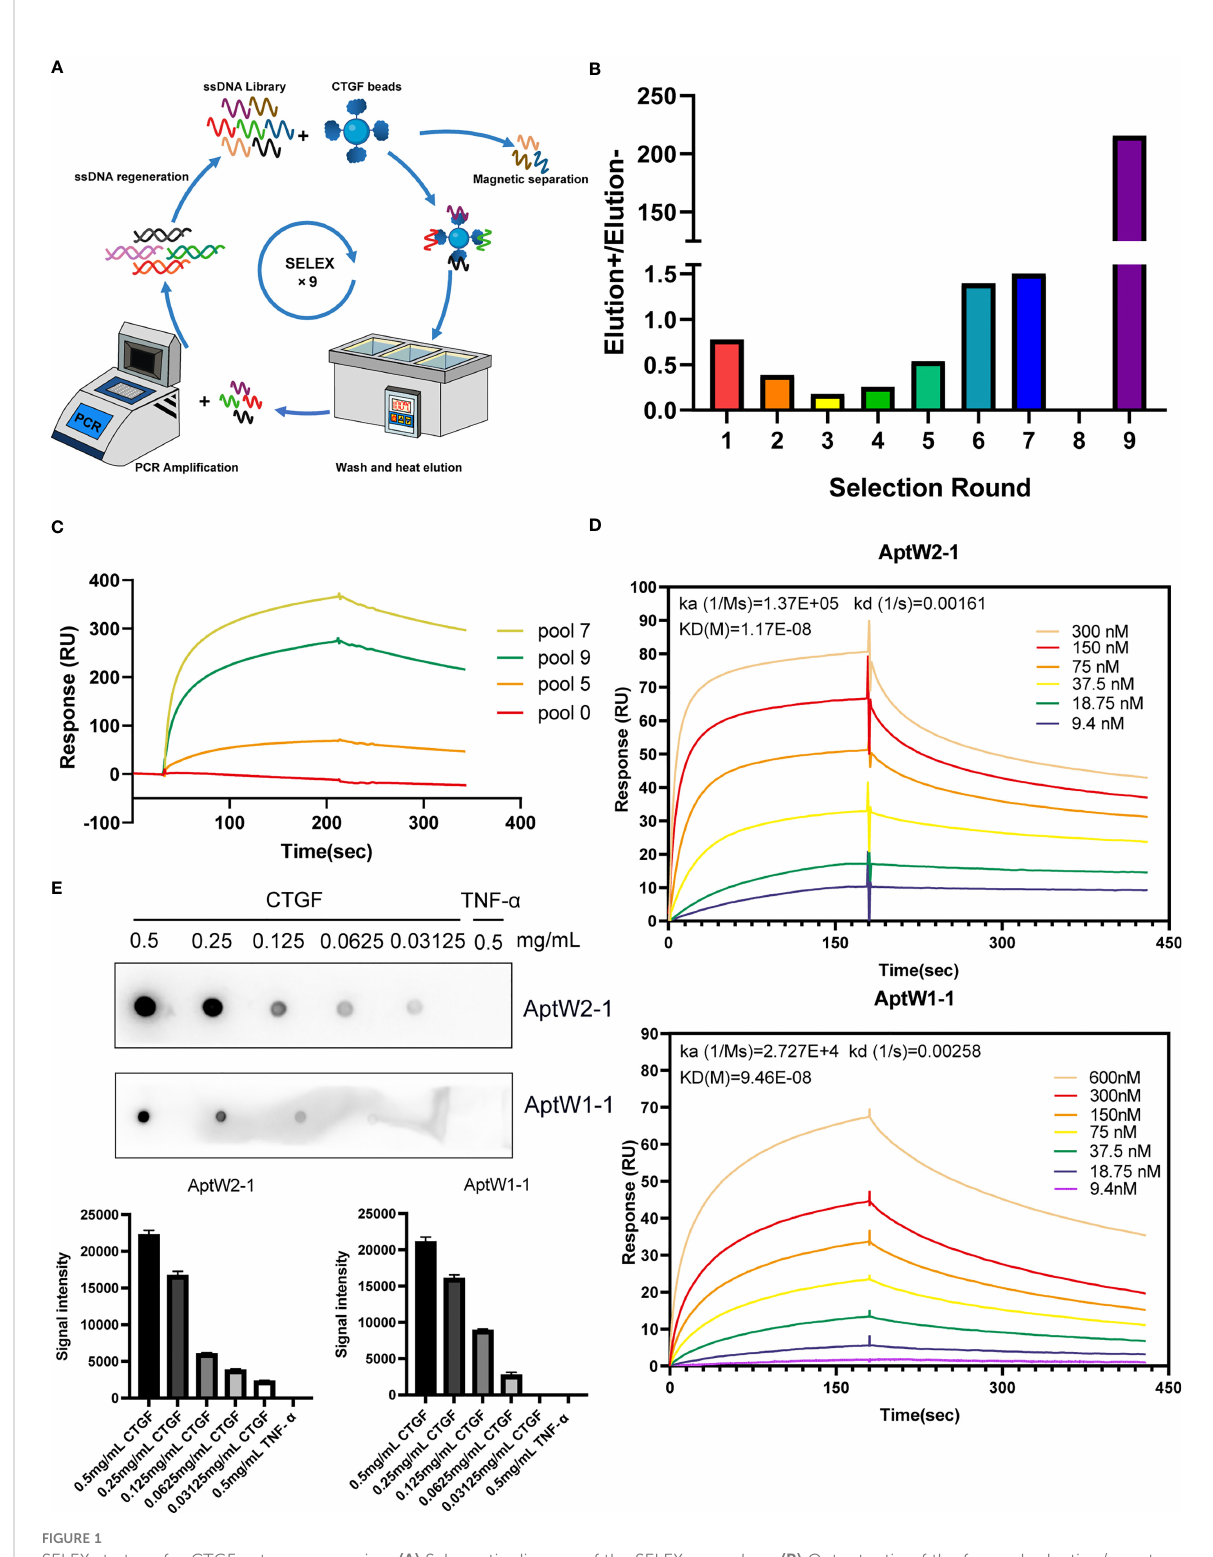
FIGURE 1 SELEX strategy for CTGF aptamer screening. (A) Schematic diagram of the SELEX procedure. (B) Output ratio of the forward selection/counter selection in successive rounds assayed using qPCR. (C) SPR assay of enriched aptamer pools targeting CTGF. (D) SPR assay of AptW2-1 and AptW1-1 targeting CTGF. (E) Dot blot assay of AptW2-1 and AptW1-1 targeting CTGF and TGF- b ,